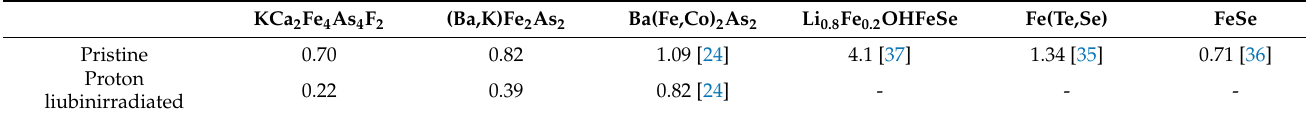
Table 1. Glassy exponents for elastic creep µ in various IBS compounds, estimated from U * vs. 1/ J plots.